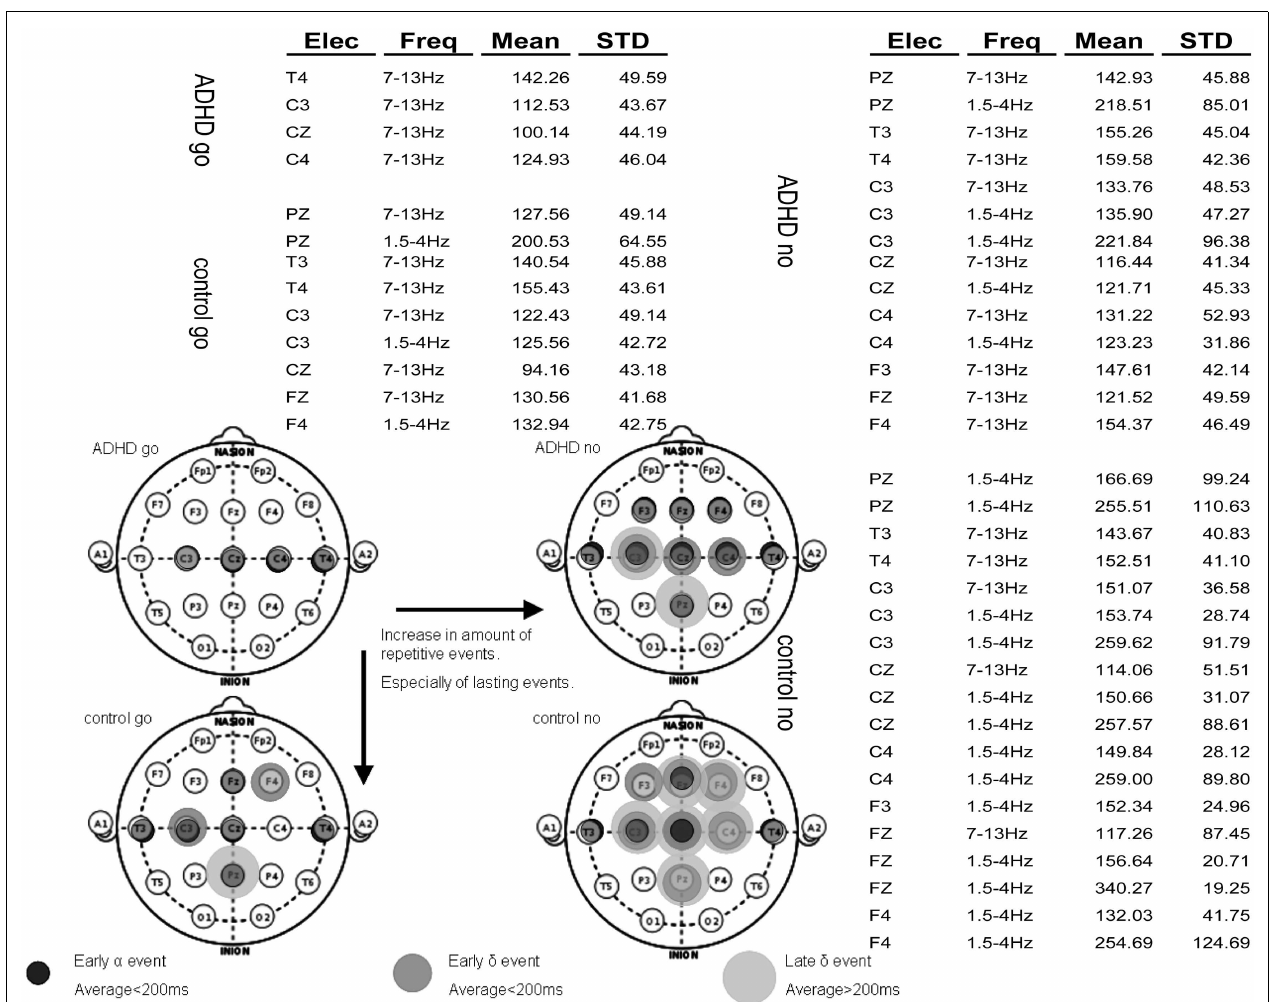
event with average peak time (across samples) below 200ms, (ii) early delta event with average peak time below 200ms, and (iii) late delta event with average peak time above 200ms.The raw data of average event time across subjects and standard deviation are presented in the background